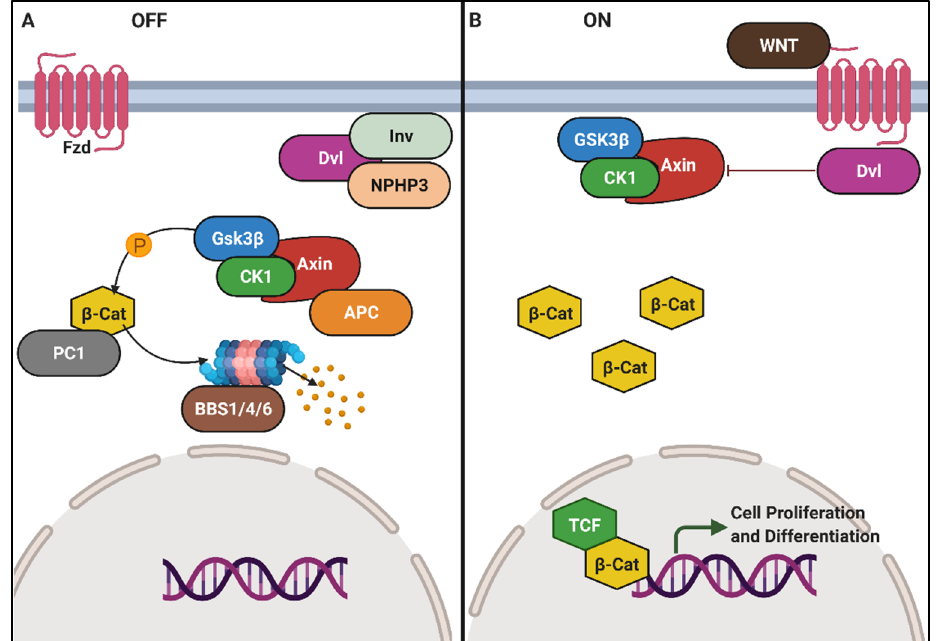
Figure 7. Canonical wingless/integrated (Wnt) signalling pathway: ( A ) In the absence of Wnt ligands, dishevelled (Dvl) forms a destruction complex with Axin, Glycogen synthase kinase-3 β (Gsk3 β ), casein kinase 1 (CK1), adenomatous polyposis coli (APC). This destruction complex phosphorylates β -catenin ( β -Cat) and triggers its proteosomal degradation. ( B ) In presence of Wnt ligands, it binds to frizzled (Fz) receptors. This phosphorylates Dvl thereby disassembling the destruction complex. β -Catenin ( β -Cat) evades proteosomal degradation and is transported to the nucleus where it dimerizes with T-cell factor/lymphoid enhancer factor (TCF). This triggers expression of cell proliferative and differentiation genes. (Modified and redrawn using BioRender.com [150] ).